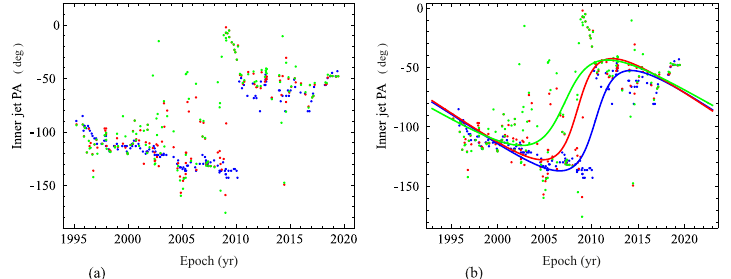
Figure 4. ( a ) Evolution of PA in of the innermost jet direction in OJ 287. Blue points correspond to the PA in estimates derived along the jet ridgelines within 0.025 mas from the 15 GHz VLBI core. Red and green points mark PA in obtained from major axis orientations of the core fitted with an elliptical Gaussian component in addition to one or two circular Gaussian components fitted to the rest of the jet, respectively. ( b ) Approximation for the observed PA in under the helical jet model. The colors of filled lines correspond to those of the observed